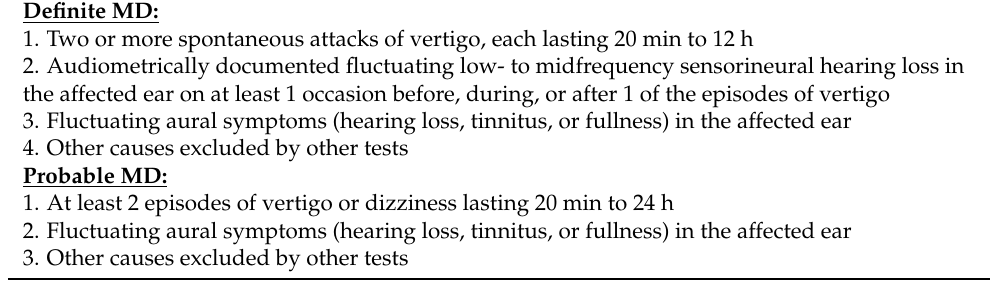
Table 1. Diagnostic criteria of MD according to 2015 AAO-HNS Equilibrium Committee